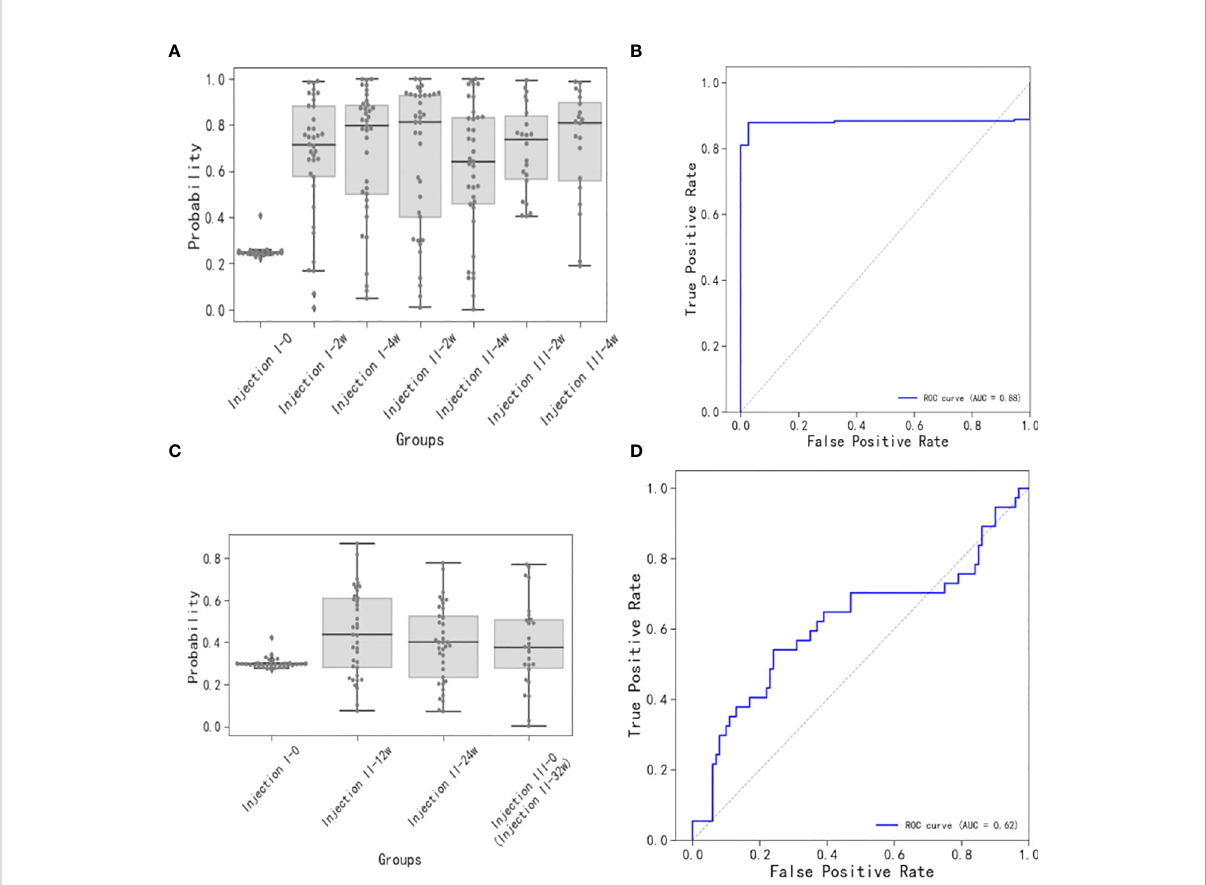
FIGURE 4 Short-term and long-term models of immune response to vaccination. (A) Distributions of short-term immune response scores. Note that the baseline sample score was ~0.25 and the post-inoculation scores were generally greater than 0.65, increasing gradually up to the Injection II- 2w assessment, then decreasing at the Injection II-4w assessment, and increasing gradually up until the Injection III-4w assessment. (B) ROC for scores over time (AUC = 0.88) for the short-term model. (C) Distributions of long-term immune response scores. Scores at the Injection II-12w assessment were slightly higher than baseline and then proceeded to decrease thereafter. (D) ROC for scores over time (AUC = 0.62) for the long-term